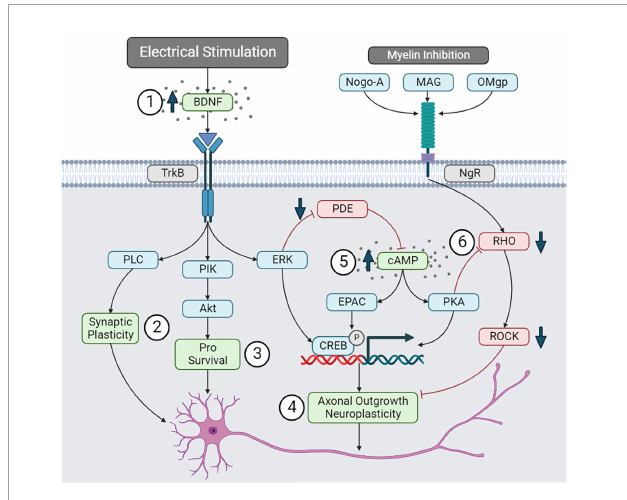
FIGURE6 Brain-derived neurotrophic factor and cAMP signaling pathways. (1) Electrical stimulation may upregulate BDNF, promoting (2) synaptic plasticity through the PLC pathway, (3) neuronal survival through the PIK-Akt pathway, and (4) axonal outgrowth through EKR and pCREB. (5) BDNF can upregulate cAMP by inhibiting PDE. cAMP may promote neuroplasticity by upregulating pCREB. (6) cAMP can also reduce myelin inhibition of axonal outgrowth by inhibiting the RHO-ROCK